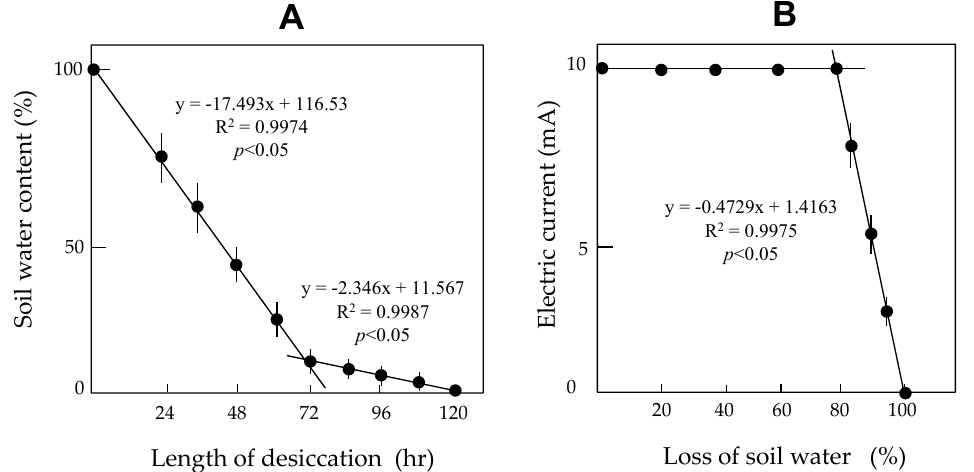
Figure 3. Relationships between duration of desiccation and loss of soil water by the loss-on-drying method ( A ) and changes in electric conductivity of soil samples with di ff erent degrees of water loss ( B ). Five soil samples were used for each duration of desiccation and each degree of water loss. Two regression lines are shown in each